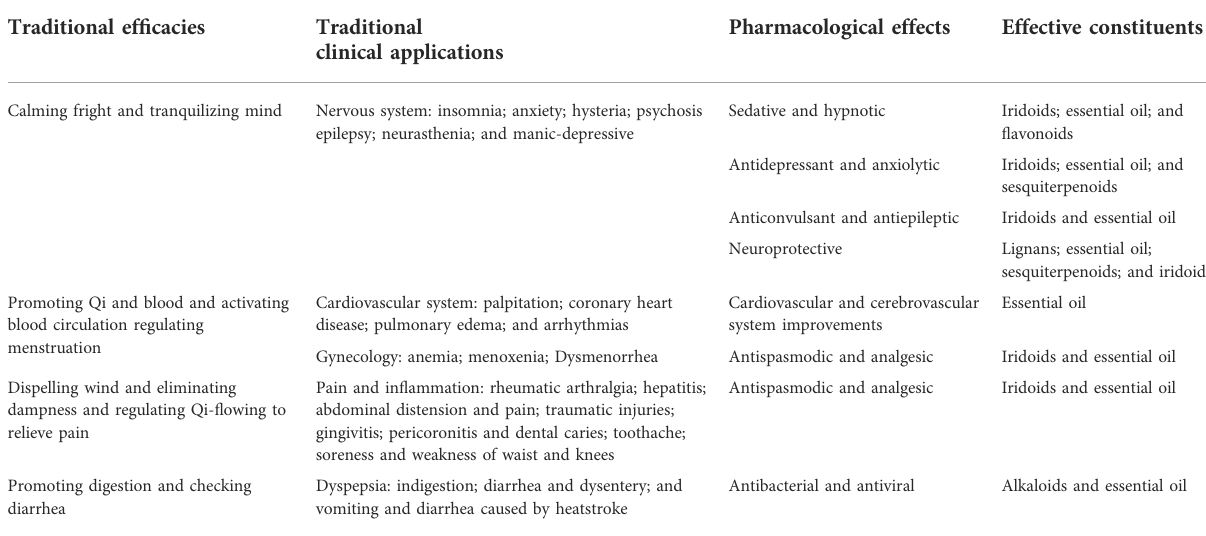
TABLE 2 Pharmacological effects and effective constituents related to traditional uses of Valeriana